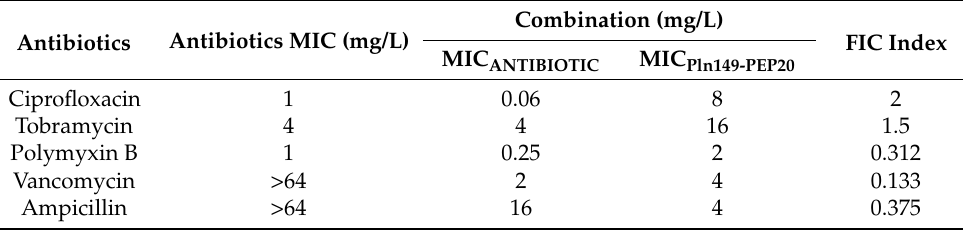
Table 4. Synergism for Pln149-PEP20 in A. baumannii ATCC 19606 (MIC = 32